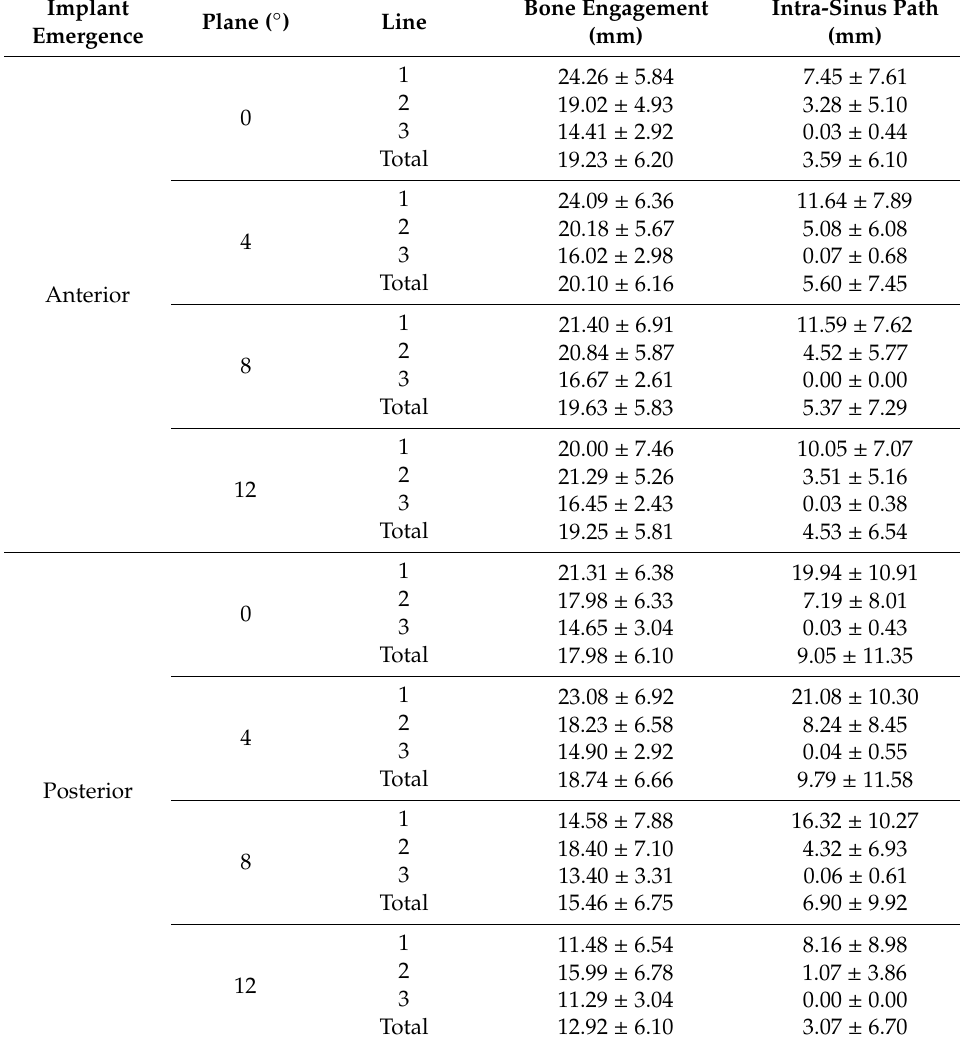
Table 3. Bone engagement and intra-sinus path on di ff erent lines and planes to anterior and posterior